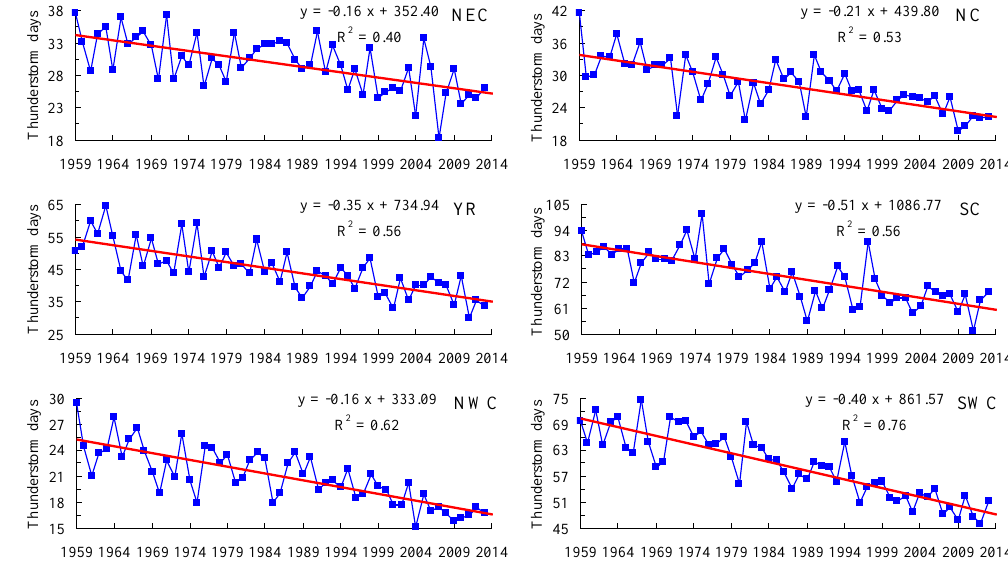
Figure 3. Variations of annual average thunderstorm days in six regions of China during 1959–2013.